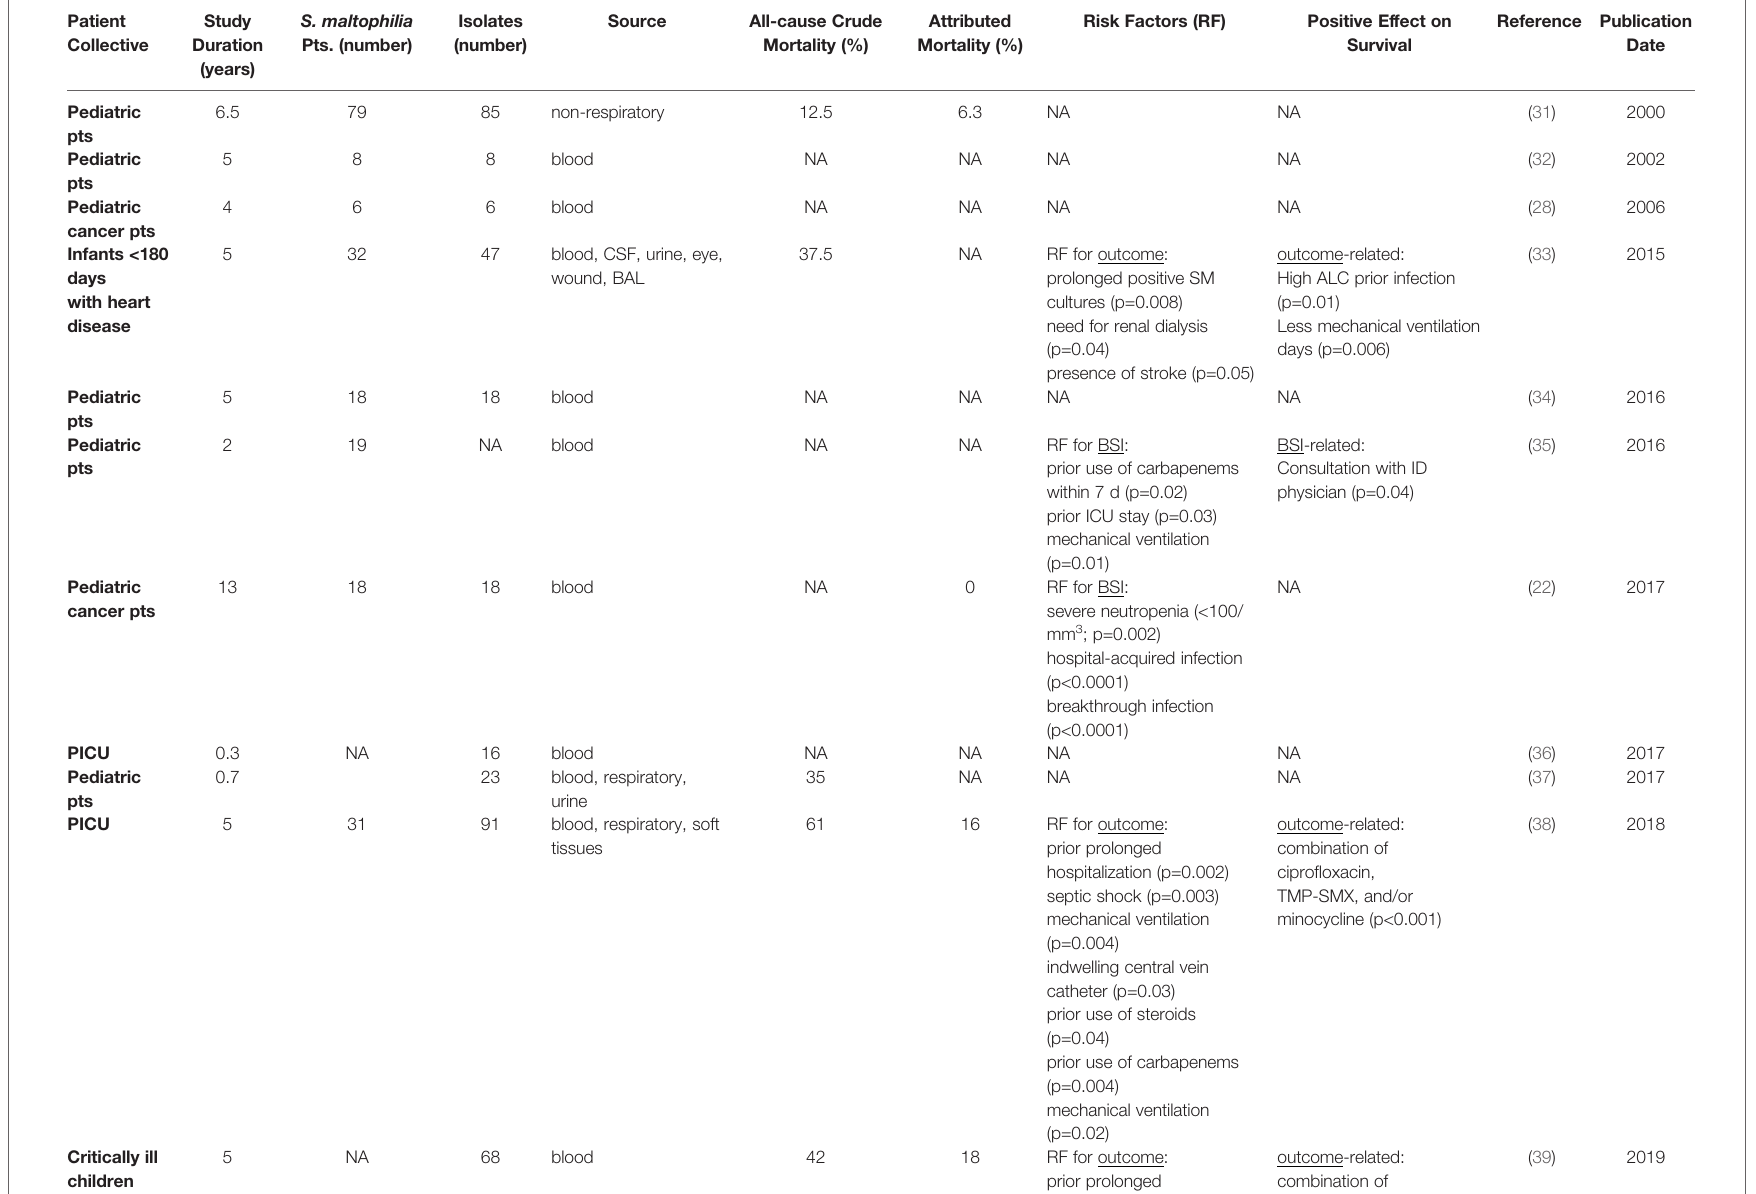
TABLE 2 | Literature overview of case series reporting blood stream infections of S. maltophilia in pediatric